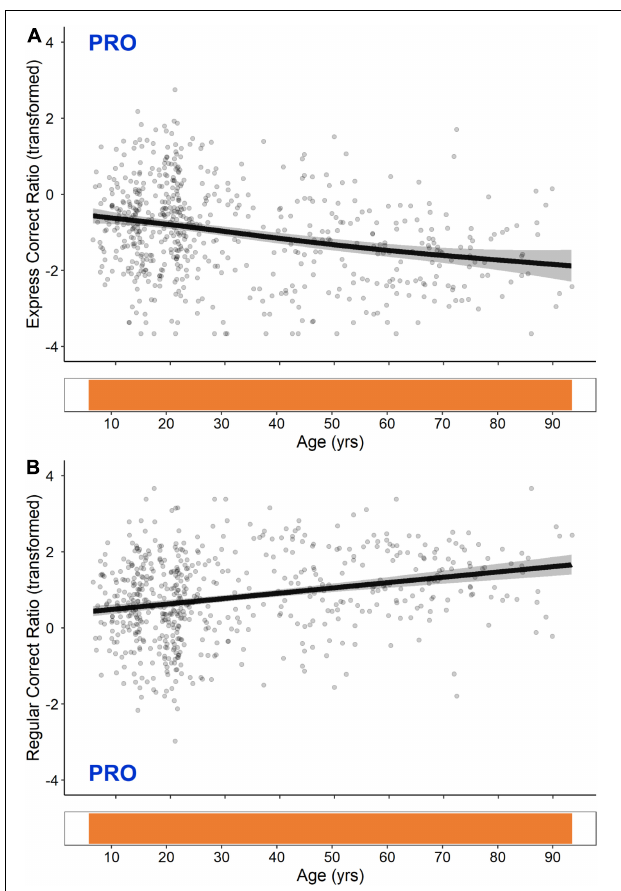
FIGURE 4 | GAM fits and significant periods of change for logit transformed PRO express-latency (A) and regular-latency (B) correct response ratios. Scatter points are individual participants, black curves are the GAM fits, and gray ribbons are the 95% confidence intervals. Bottom tiles indicate significant periods of change. Note that these are continuous across the entire lifespan.